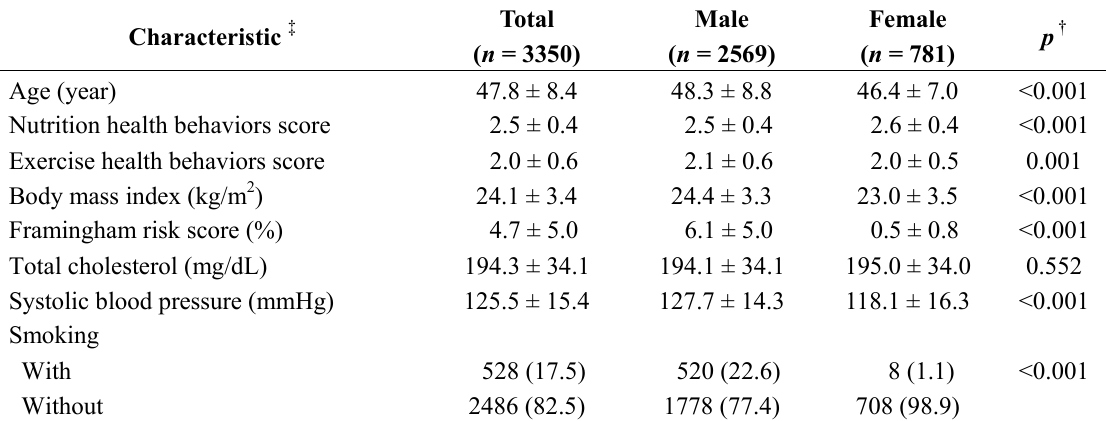
Table 1. Descriptive statistics of the participants’ personal characteristics by gender.